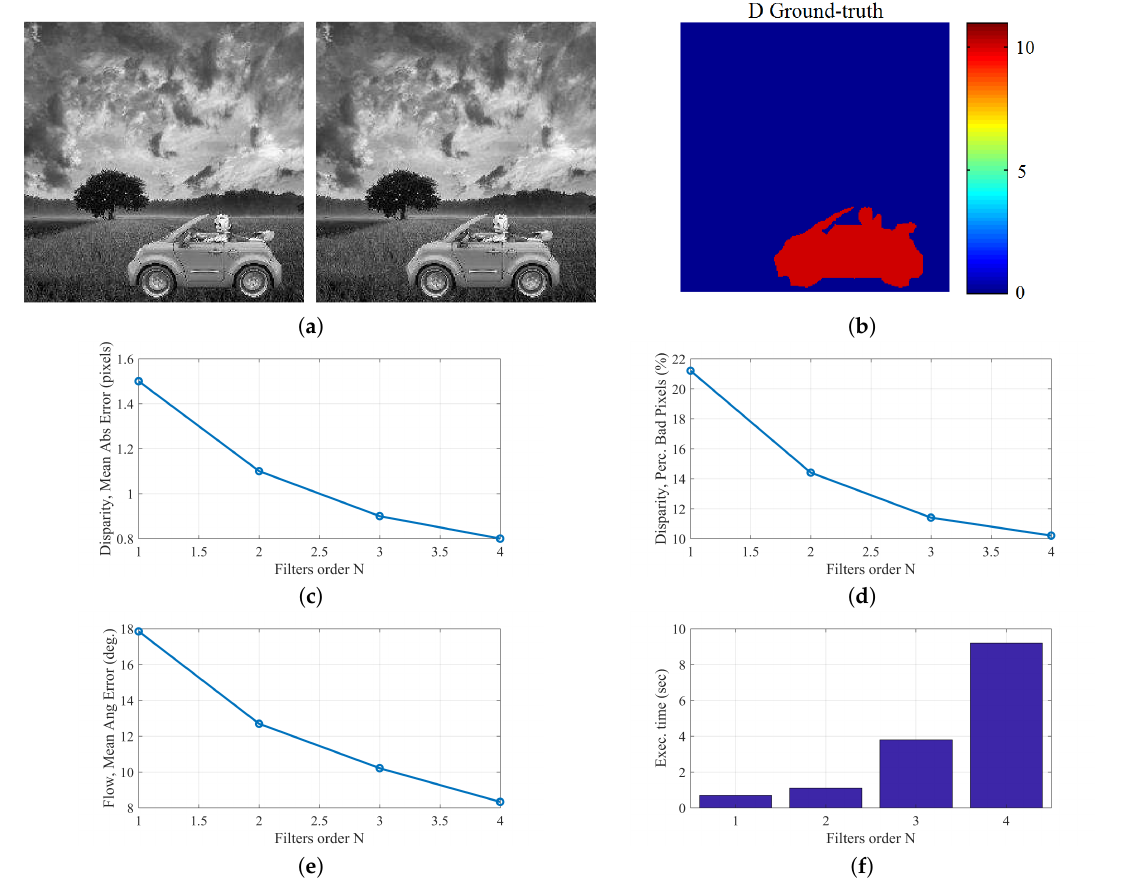
Figure 2. Simple artificial “Car-Tree” sequence: results with respect to the filters’ order N . The results were obtained by applying WTA directly to the initial cost volume C ( x s ; u , D ) : ( a ) first and last (sixth) frame of the left view and ( b ) ground-truth disparity map; ( c ) mean absolute disparity error and ( d ) percentage of bad pixels; ( e ) flow mean angular error; ( f ) computational time.